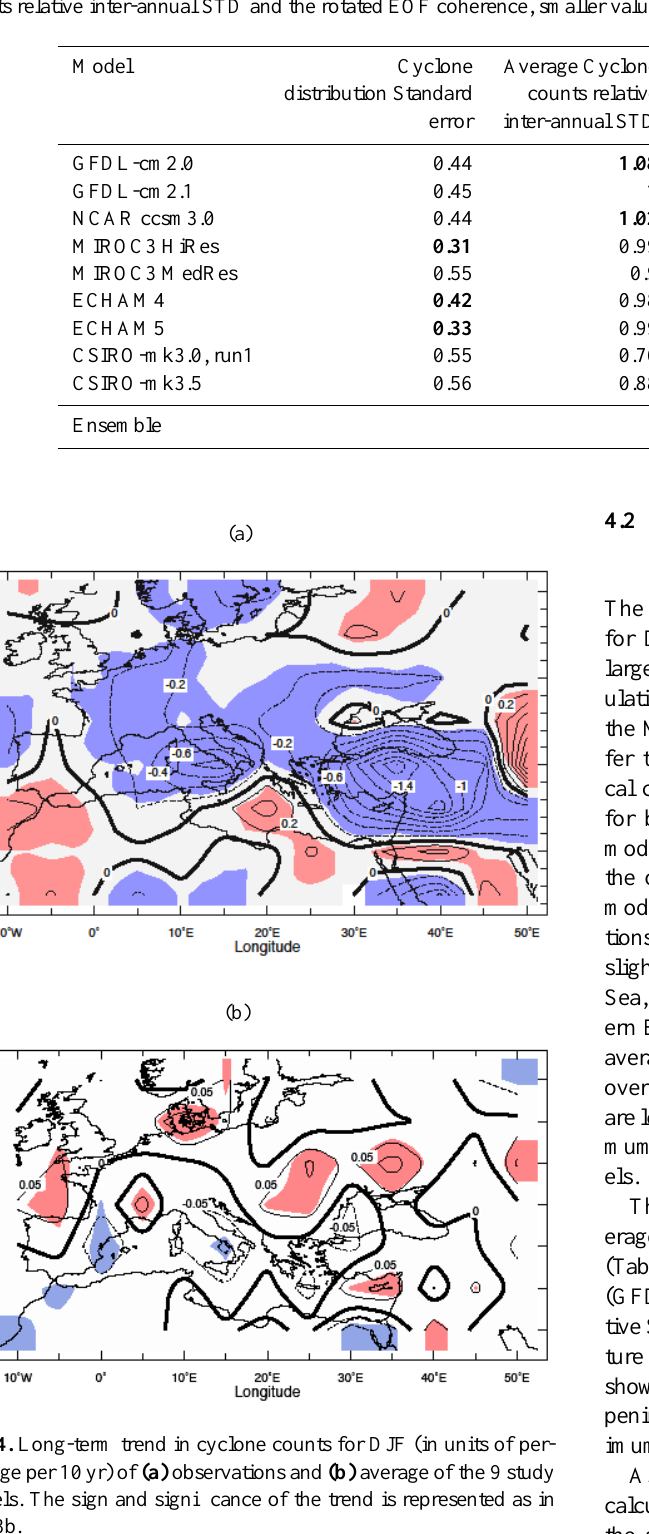
Table 3. List of quantitative estimates for the ability of the 9 study models to reproduce the observed synoptic features. The results for the 3 models with the highest score in each category are indicated in bold letters. Note that for all of the estimates, excluding the Average Cyclone counts relative inter-annual STD and the rotated EOF coherence, smaller values reflect better performance.